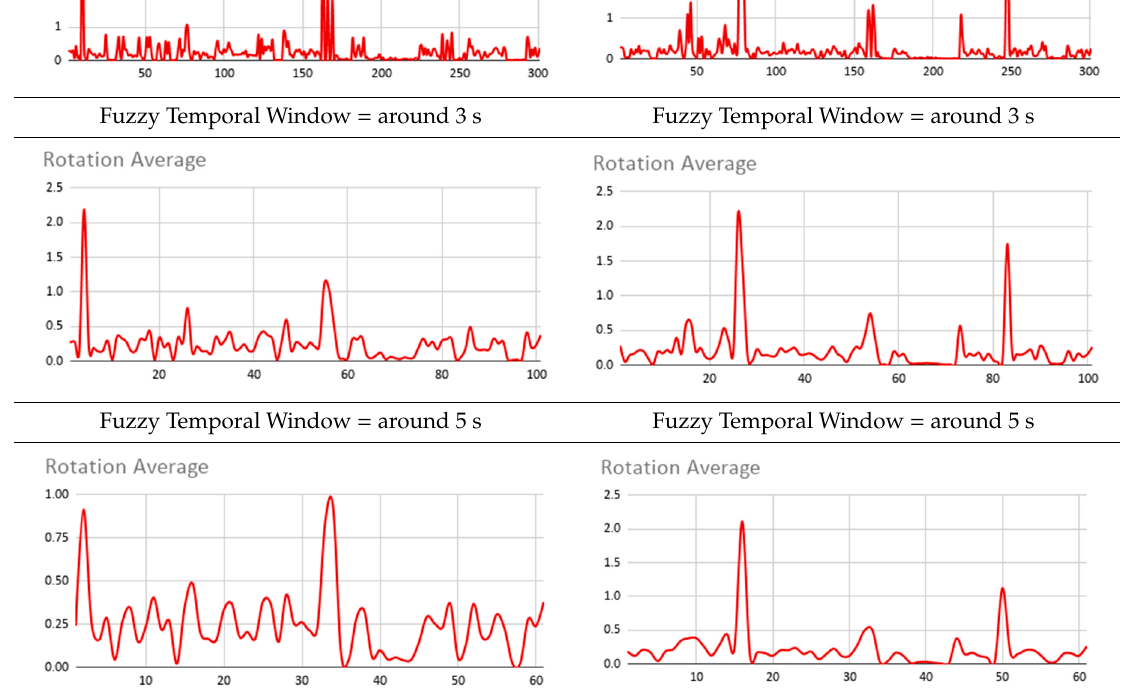
Table 6. Heart results with different fuzzy temporal windows from both wrists.